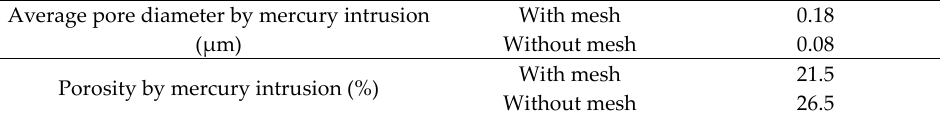
Figure 10. Porosimetry properties obtained by mercury intrusion of hydraulic lime mortar applied to lightweight concrete block substrate, with and without mesh. Table 9. Hydraulic lime mortar applied to the solid ceramic brick substrate.